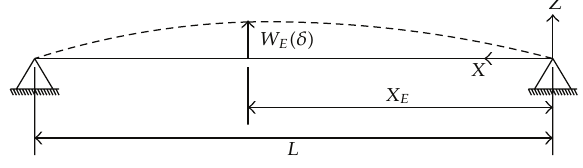
Figure 21: Elastic deformation of a transversal